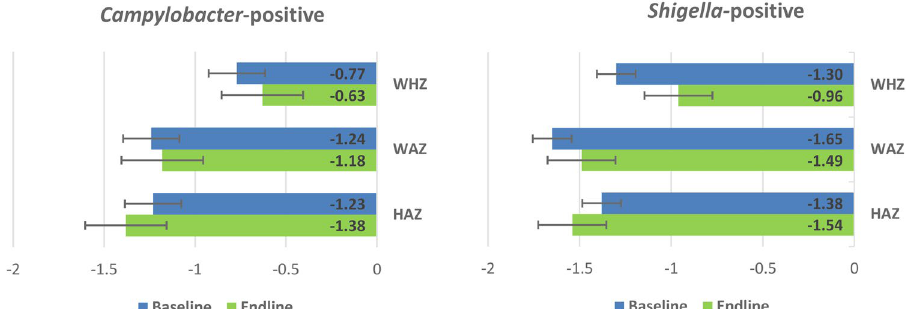
Figure 1. Mean baseline and endline height-for-age z score (HAZ), weight-for-age z score (WAZ), and weight- for-height z score (WHZ) among the fecal Shigella -positive and Campylobacter -positive under 5 children from